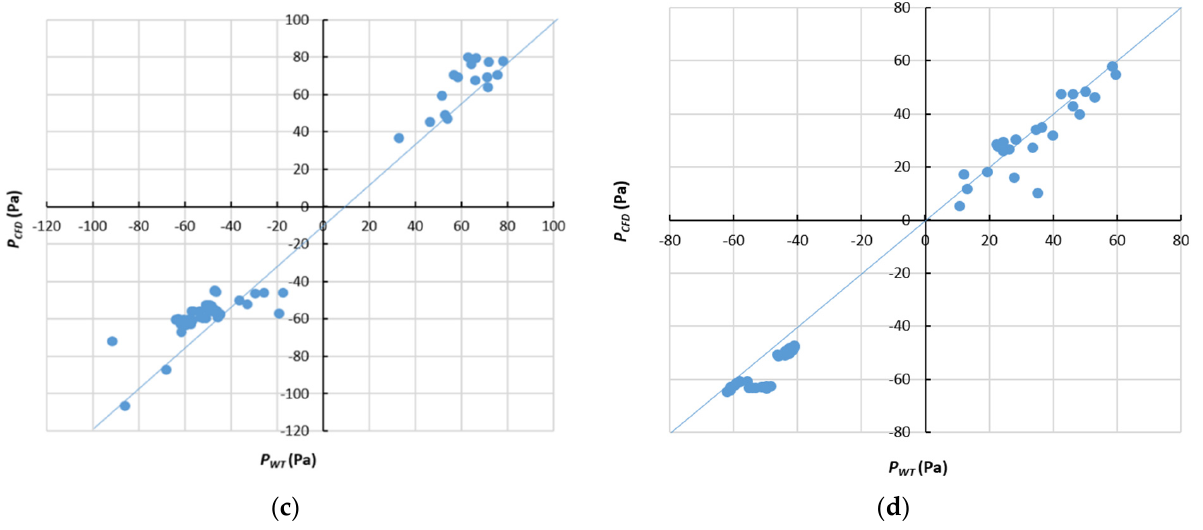
Figure 10. Wind pressures on an atypical structure: CFD vs. WT tests, wind directions. ( a ) 0°; ( b ) 45°; ( c ) 67.5°; ( d ) 180°.